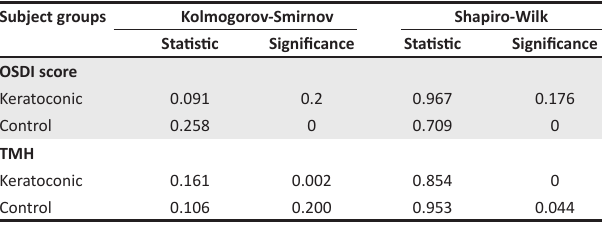
TABLE 1: Kolmogorov-Smirnov and Shapiro-Wilk tests for the normality of data. Subject groups